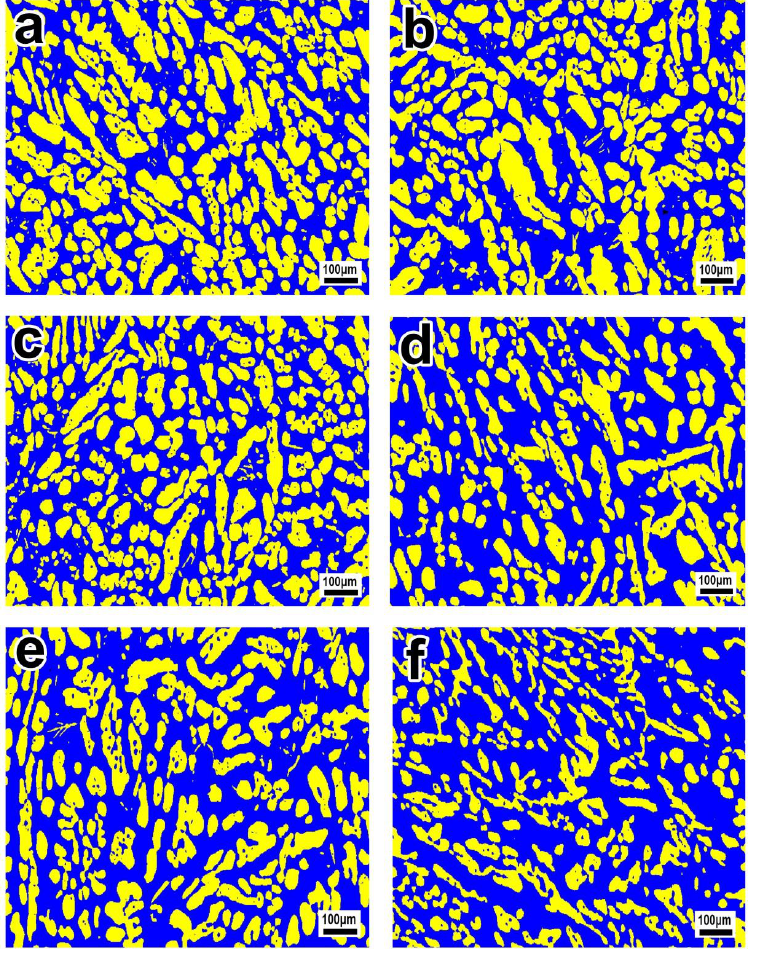
Figure 2. Electron backscattered diffraction ( EBSD) phase maps of S32750 stainless steel sample at different annealing temperatures for 35 min: ( a ) 950, ( b ) 1000, ( c ) 1050, ( d ) 1100, ( e ) 1150, and ( f ) 1200 °C. The blue region is ferrite and the yellow region is austenite.